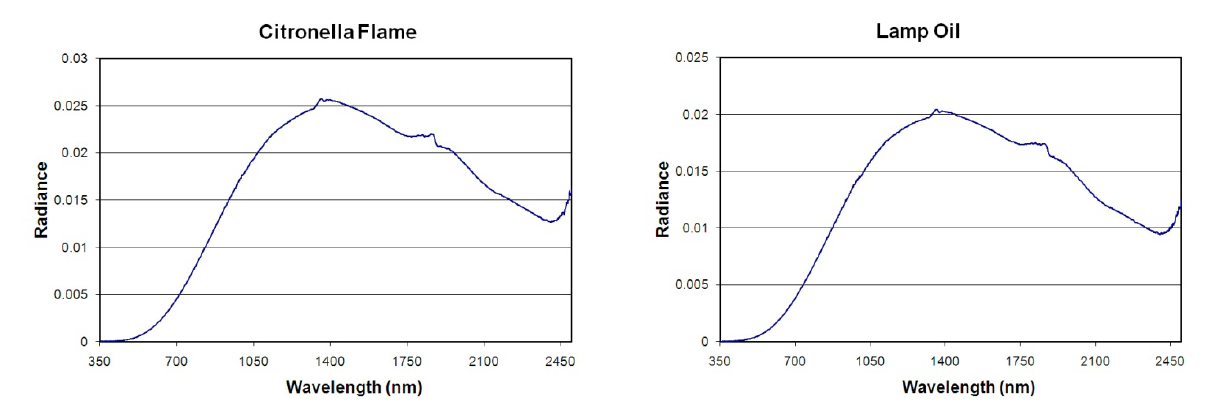
Figure 5. Emission spectra of lamps burning liquid fuels largely exhibit blackbody